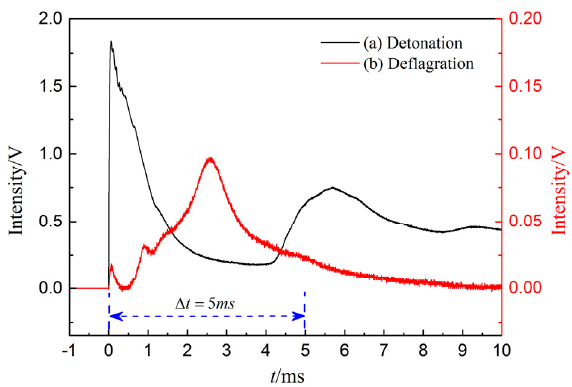
Figure 8. Radiation signal intensity of detonation and deflagration.